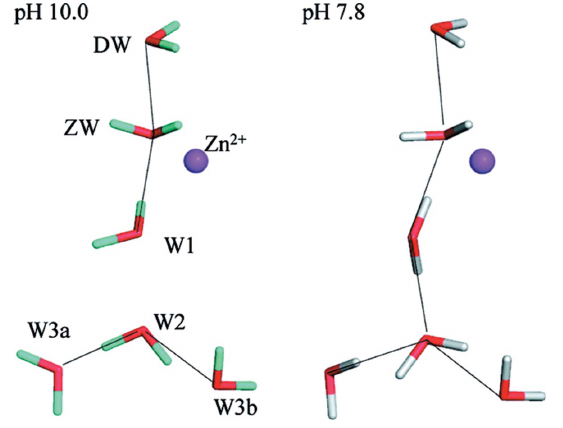
Figure 10 Water-relay network within CA, showing a difference in the orientation of water W1 between pH 7.8 (active) and pH 10.0 (inactive). Reprinted with permission from Fisher et al. (2011), Biochemistry , 50 , 9421–9423. Copyright (2011) American Chemical